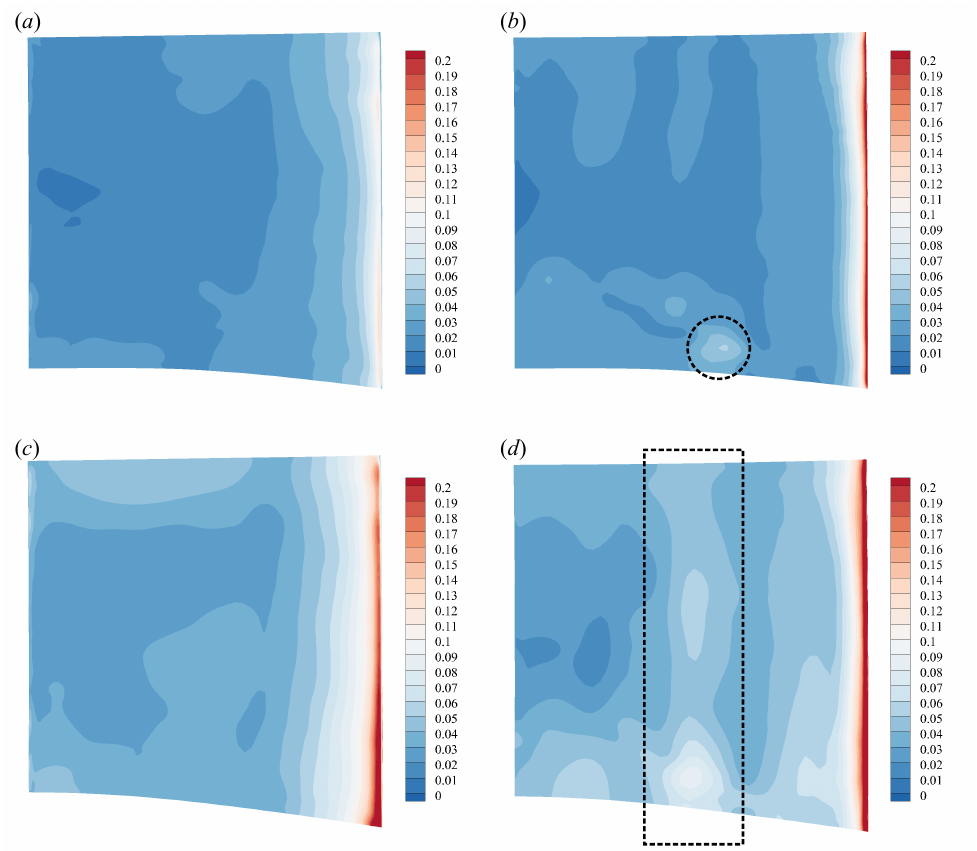
Figure 23. Distributions of the pressure fluctuation amplitude on the stator blade. ( a ) g = d 0 , pressure surface, ( b ) g = d 0 , suction surface, ( c ) g = 0.1 d 0 , pressure surface, ( d ) g = 0.1 d 0 , suction